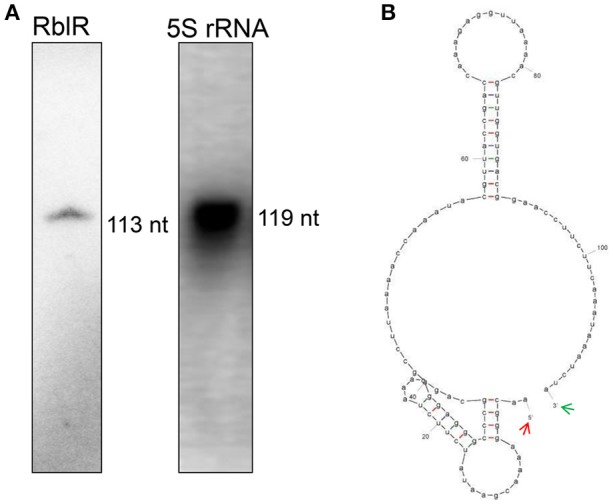
Identification of the asRNA RblR. (A) Typical detection pattern of RblR and 5S rRNA by RNA blot analysis. Five micrograms of total RNA was loaded for detection of 5S rRNA. Eighty micrograms of total RNA was applied to the lane labeled RblR. (B) RNA secondary structure prediction for RblR. Arrows indicate experimentally detected RNA 5′ (red) and 3′ (green) ends.